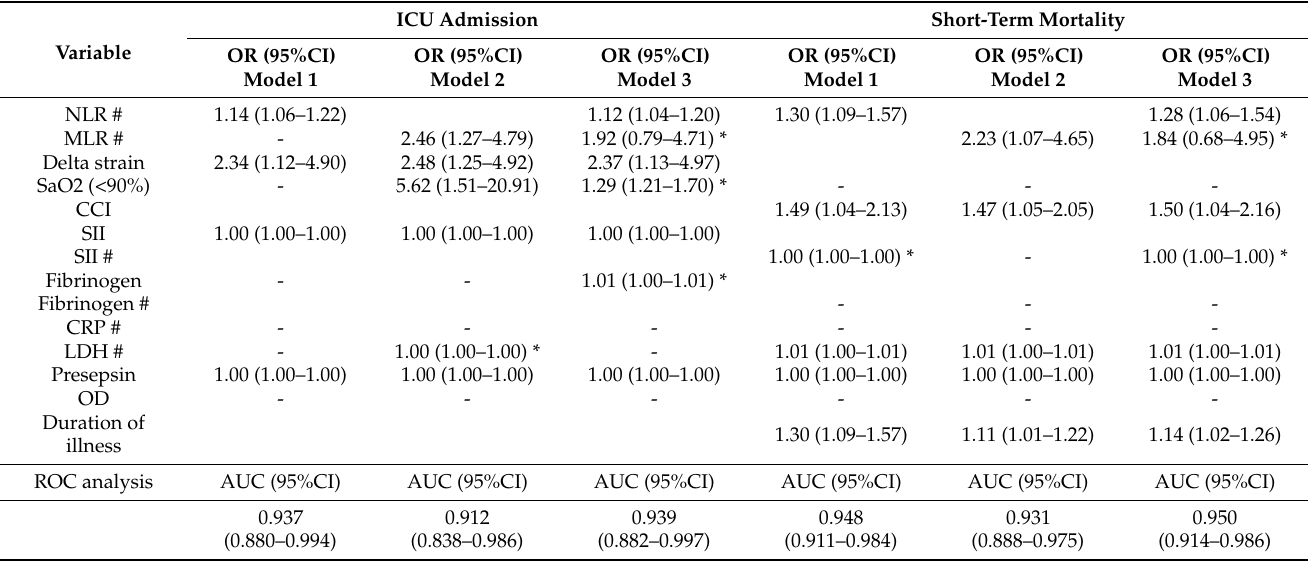
Table 4. Logistic regression models testing NLR, MLR and other inflammatory biomarkers in relation to the main